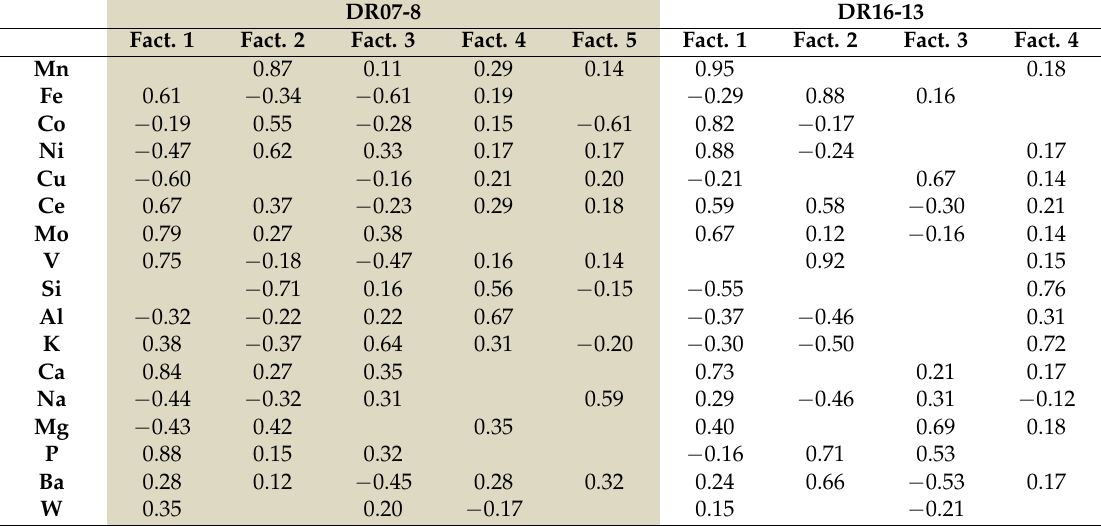
Table 3. Results of the Varimax factor analysis conducted on the set of EPMA layer-by-layer analyses of both studied crusts. The back color is to differentiate both samples. DR07-8 DR16-13 Fact. 1 Fact. 2 Fact. 3 Fact. 4 Fact. 5 Fact. 1 Fact.